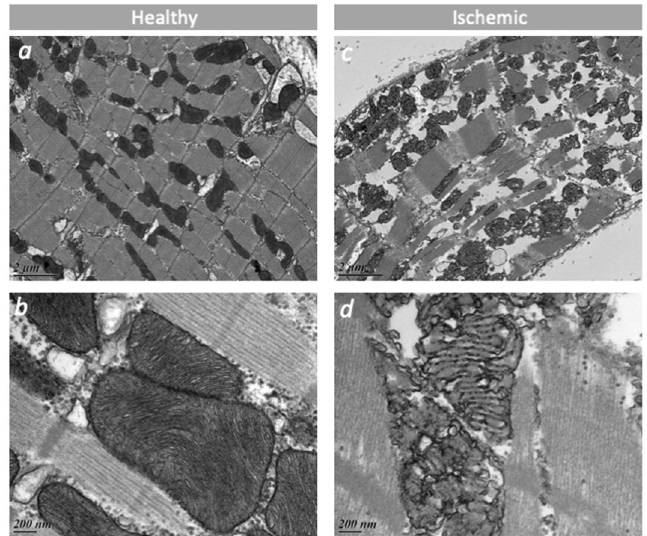
Figure 4. Electron microscopy of healthy (left panel: a , b ) and infarcted (right panel: c , d ) myocardium from two representative animals, one CS and one SHAM. ‘ a ’ and ‘ c ’ scale: 2 μm; ‘ b ’ and ‘ d ’ scale: 200 nm. In the healthy non-ischemic zone, mitochondria are aligned along the normally structured muscle fibres ( a ), very dense, not swollen and the inner membrane folding (Cristae) are well preserved ( b ). In the ischemic zone, the mitochondrial network is disorganized ( c ), mitochondria are swollen, the inner membrane folding (Cristae) is completely altered ( d